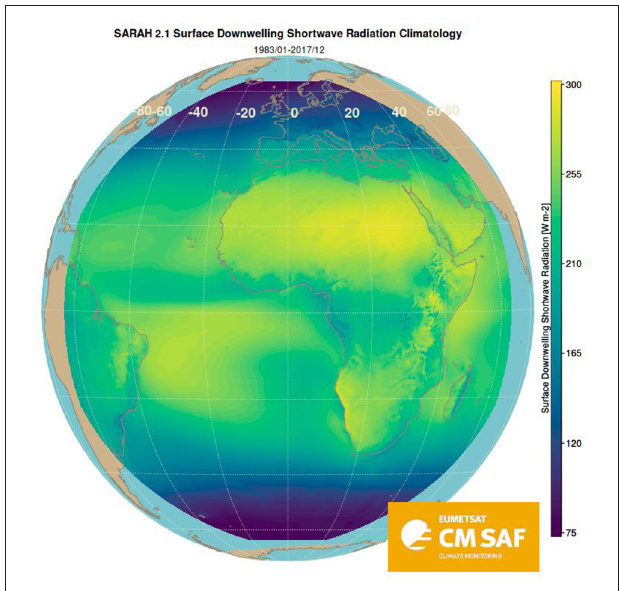
FIGURE 8 | Spatial distribution of mean surface solar radiation (global radiation) in the period 1983–2017 based on the CM SAF SARAH-2.1 data set.